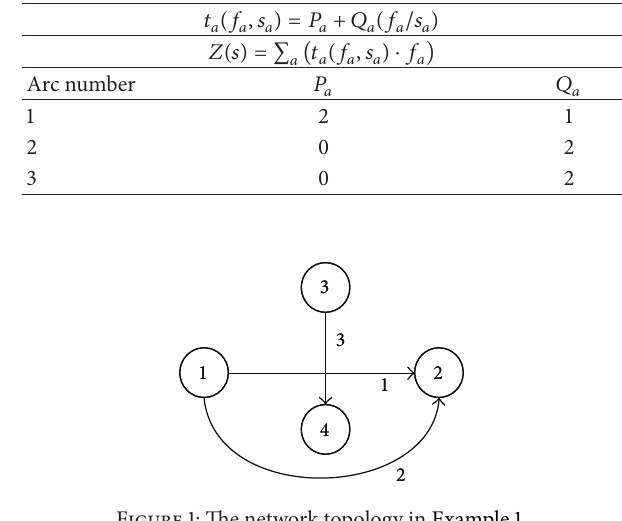
Figure 1: The network topology in Example